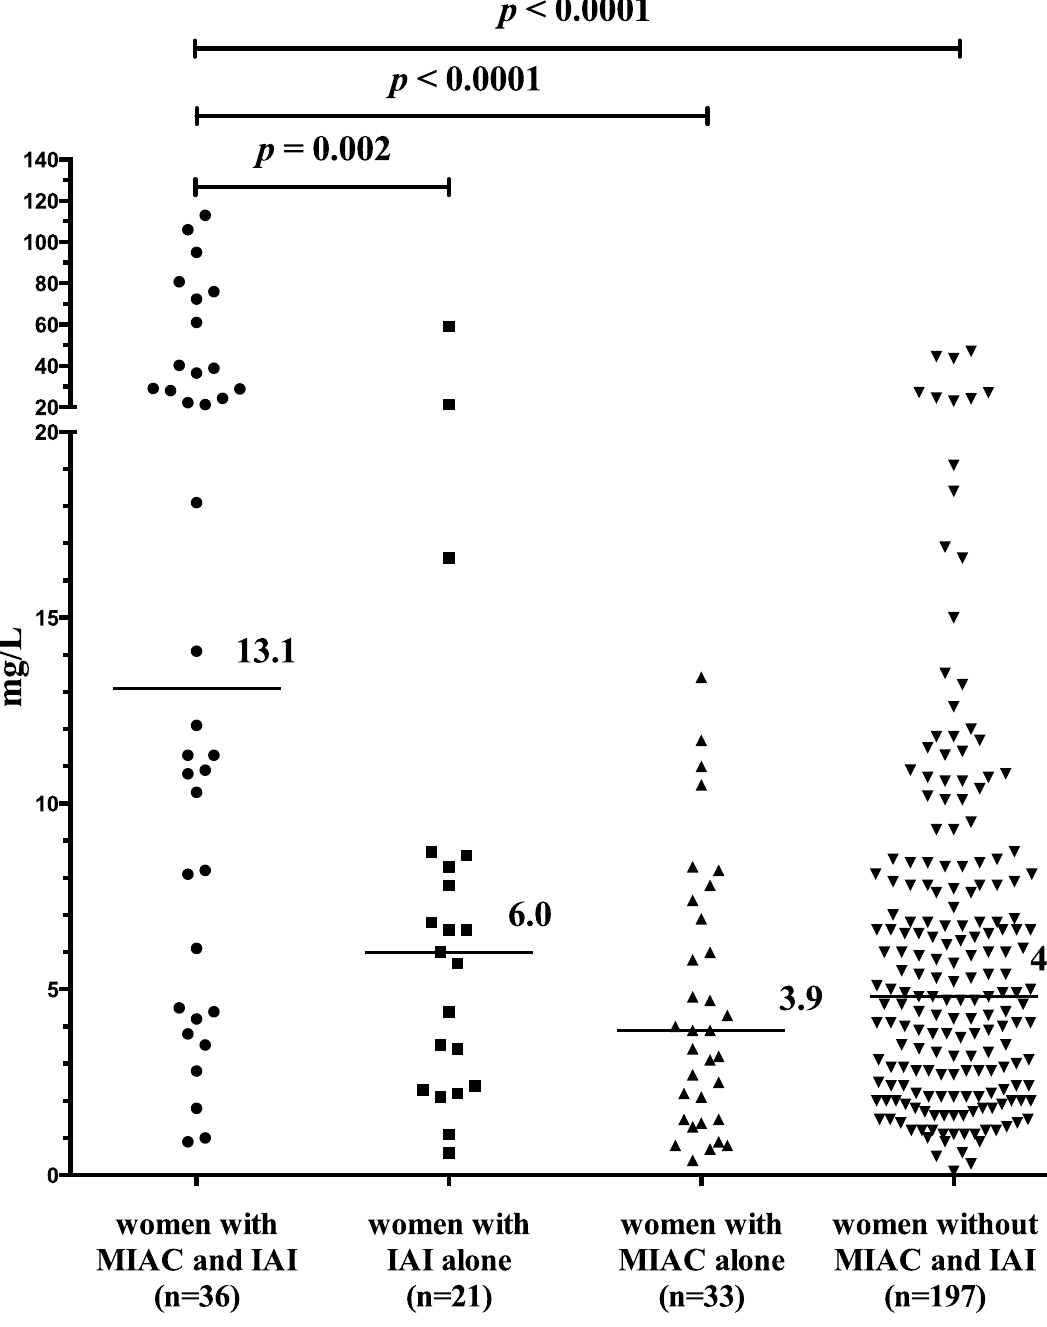
PLOS ONE | https://doi.org/10.1371/journal.pone.0182731 August 16,